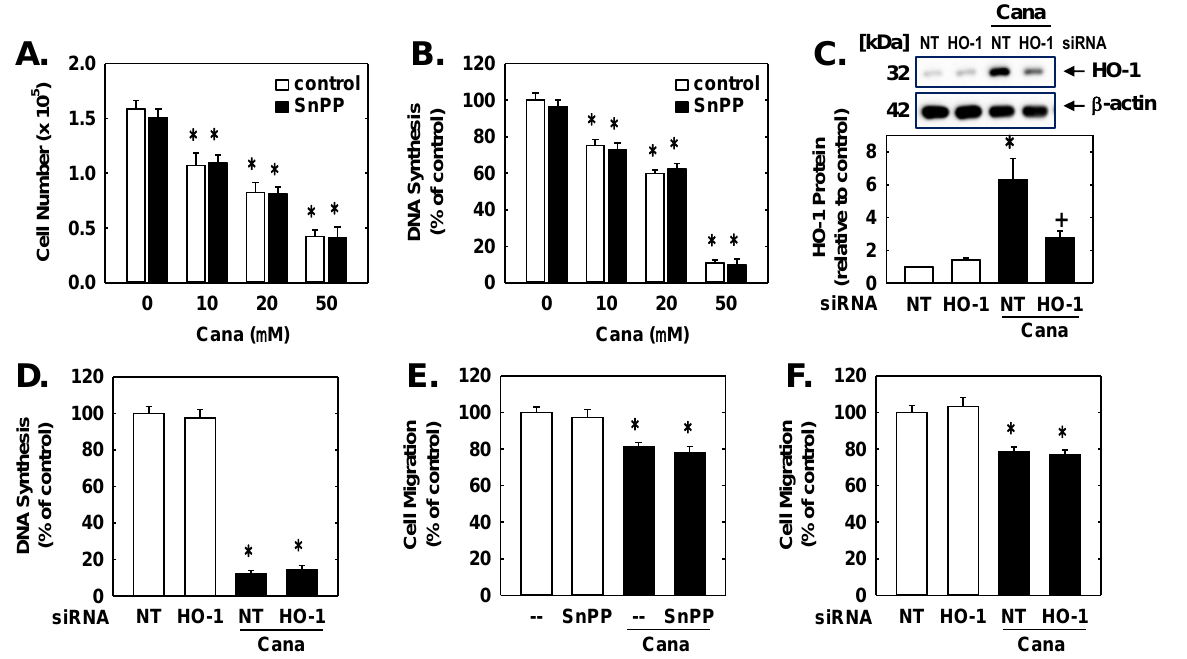
Figure 2. Canagliflozin (Cana) inhibits human EC proliferation, DNA synthesis and migration in a HO-1-independent manner. ( A ) Effect of Cana (0 – 50 µM) treatment for 96 h on cell proliferation in the presence and absence of the HO inhibitor SnPP (10 µM). ( B ) Effect of Cana (0 – 50 µM) treatment for 24 h on DNA synthesis in the presence and absence of SnPP (10 µM). ( C ) HO-1 expression in ECs transfected with NT or HO-1 siRNA (100 nM) and then exposed to CANA (50 µM) for 24 h. ( D ) Effect of HO-1 silencing on Cana-mediated inhibition of EC DNA synthesis. Cells were transfected with NT and HO-1 siRNA (100 nM) and then exposed to Cana (50 µM) for 24 h. ( E ) Effect of Cana (50 µM) treatment for 24 h on the migration of ECs in the presence and absence of SnPP (10 µM). ( F ) Effect of HO-1 silencing on Cana-mediated inhibition of EC migration. Cells were transfected with NT and HO-1 siRNA (100 nM) and then exposed to Cana (50 µM) for 24 h. Results are mean ± SEM ( n = 4 – 6). * Statistically significant effect of Cana. + Statistically significant effect of HO-1 siRNA.